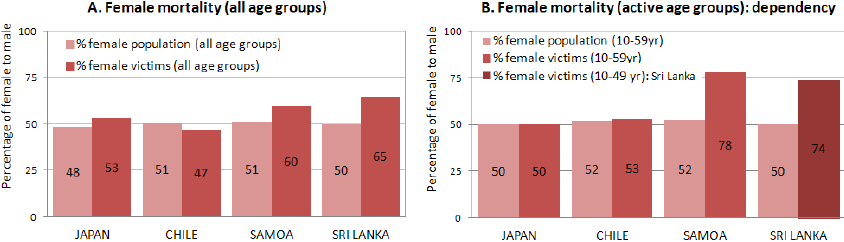
Figure 10. Female mortality for different tsunami events and its relationship with the concept of dependency (tsunami events of Japan 2011, Chile 2012, Samoa 2009 and Sri Lanka 2004). Pre-tsunami censuses appear in light red and tsunami victims in dark red. Panel (a) shows female mortality considering all age groups and panel (b) shows female mortality considering only the active age groups (10–59years old for Japan, Chile and Samoa, while 10–49years old for Sri Lanka due to data availability), assuming that women in this age range may have been in charge of family members (children and the elderly). Higher percentages of female victims in the active age group compared to the pre-tsunami percentages provide the female mortality associated with dependency